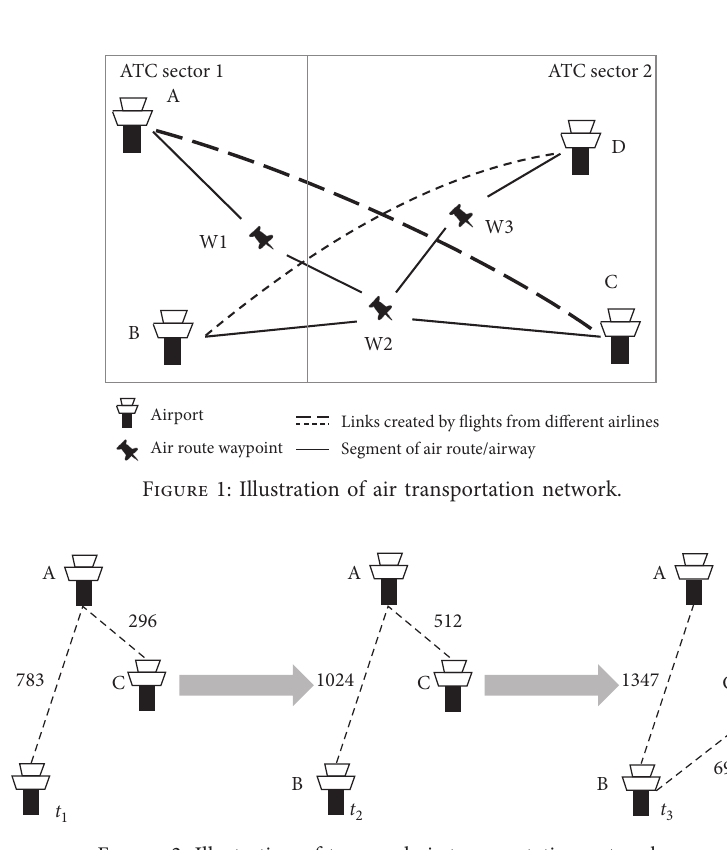
Figure 2: Illustration of temporal air transportation network.